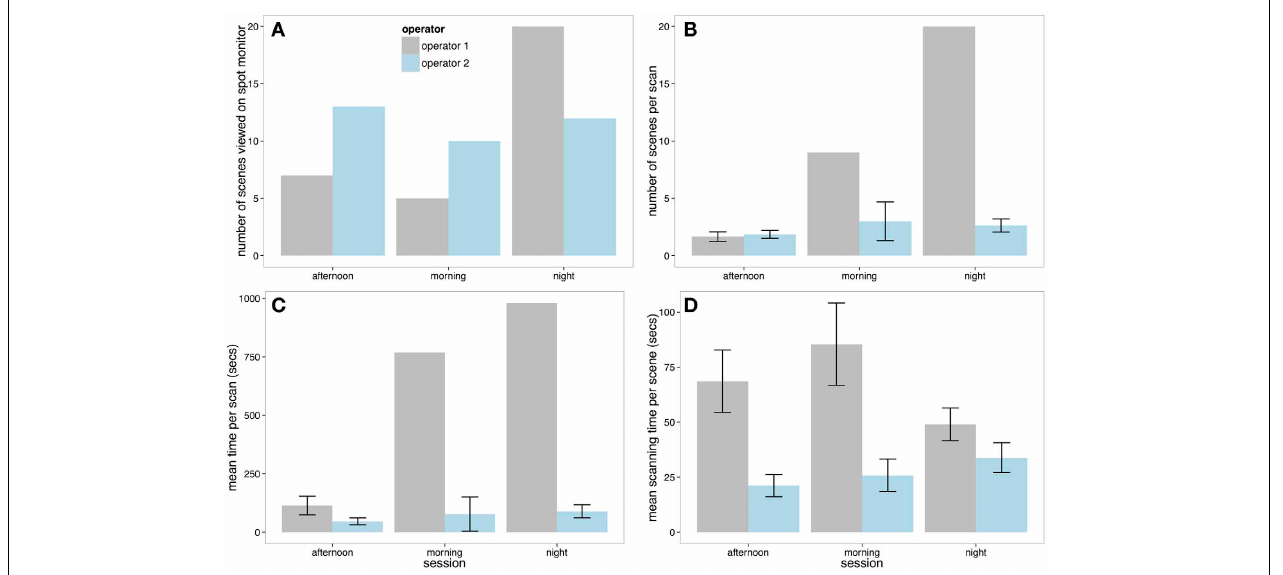
FIGURE 4 | (A) Total number of scenes viewed on the spot monitor on each session by each operator. (B) The number of scenes selected by each operator per scan. This figure shows that Operator 1 selected more screens than Operator 2 (and this was unbroken in